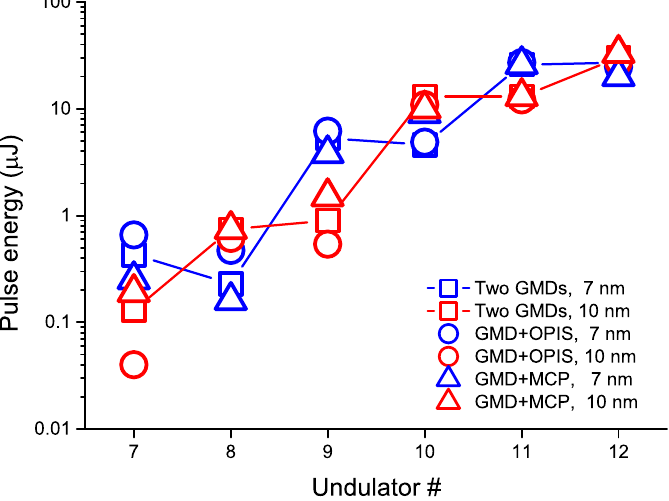
Figure 4. Gain curve of two-color lasing. Pulse energies at 7 nm (blue) and at 10 nm (red) versus the undulator segment number. Measurements were carried out with three methods: two GMDs (squares), GMD+OPIS (circles), and GMD+MCP (triangles).The figure was published in